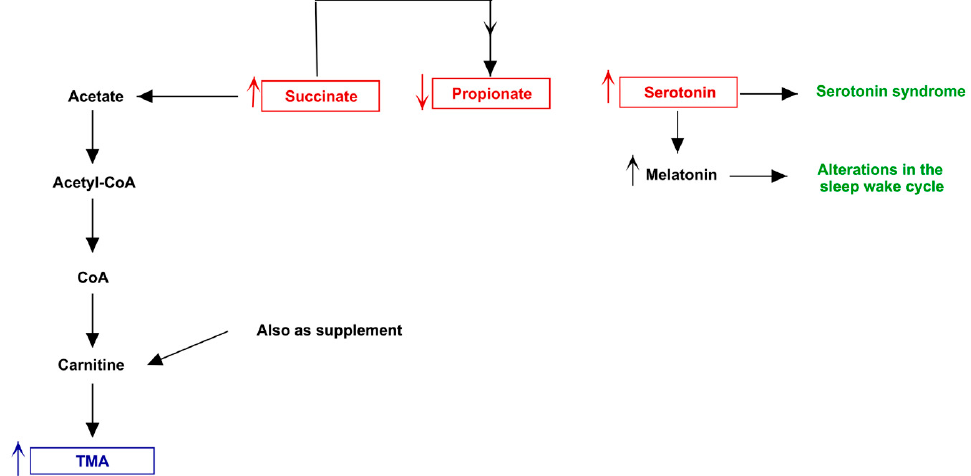
Figure 9. Biochemical pictures of TMAU patient 3. The panel represents how metabolites produced directly or indirectly by patient’s microbiota could influence the biosynthesis/release of neurotransmitters (in particular serotonin) and the production/accumulation of